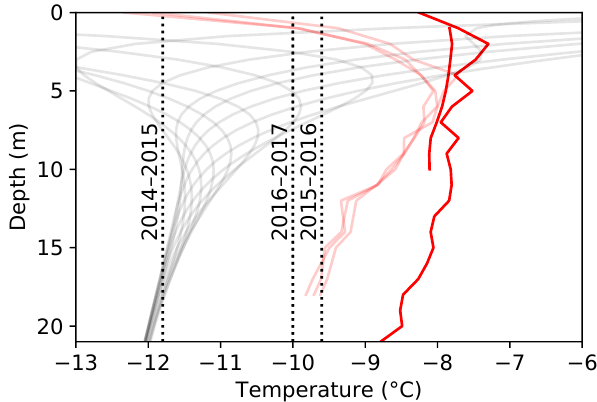
Figure 6. A comparison of model output (gray) and data from 33km-14, including mean ice temperatures (red) and mean annual air temperatures for three seasons (black dashed). The observed ice temperatures are plotted the same as in Fig. 2. Note that three of the temperature strings collected only ∼ 9 months of data (transparent red). Mean temperatures from those three strings are cold near the surface because they collected more measurements in wintertime than